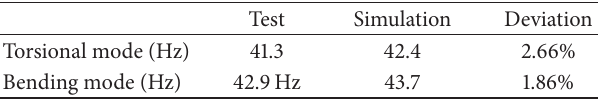
Table 9: The test result of E-REV vehicle modality after lightweight- ing the main